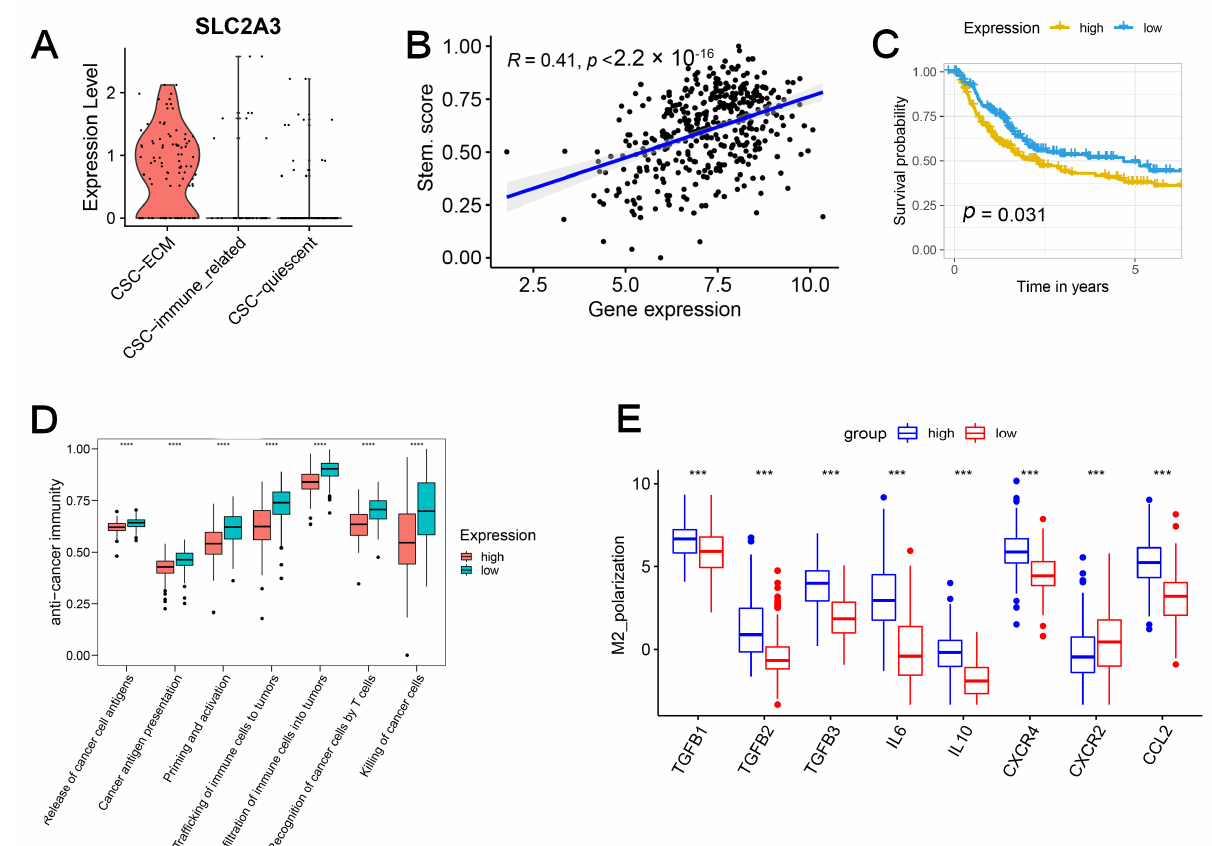
Figure 7. SLC2A3 is upregulated in ECM-related CSCs and related to impaired cancer-immunity cycle. ( A ) SLC2A3 was upregulated in ECM-related CSCs. ( B ) Positive correlation between the ex- pression of SLC2A3 and stemness enrichment score. ( C ) Overexpressed SLC2A3 indicated a worse prognosis. ( D ) Overexpressed SLC2A3 indicated an impaired cancer-immunity cycle. ( E ) M2 mac- rophage polarization factors were upregulated in the high-expression group.